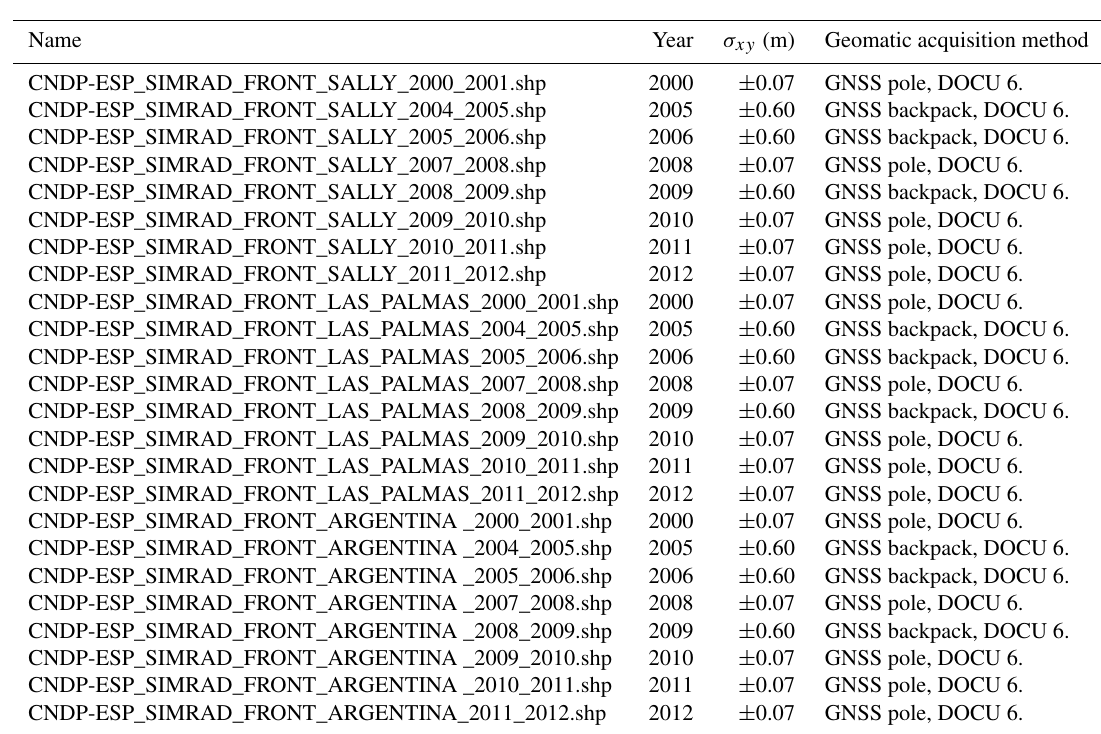
Table 6. ARCGIS shape files corresponding to the GSNCI data inventory for Argentina, Las Palmas and Sally Rocks fronts of Hurd Glacier, determined using GNSS techniques. In the third column the RMS error is